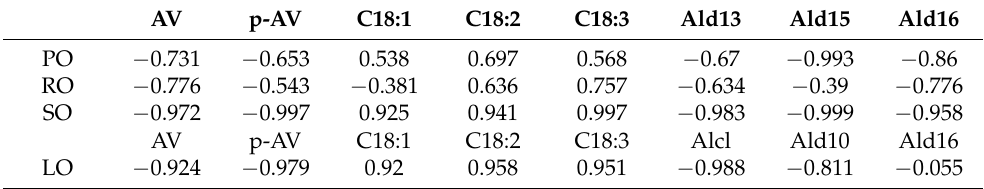
Table 5. Pearson correlation coefficient between free radical and input layer neurons of ANN in oils.